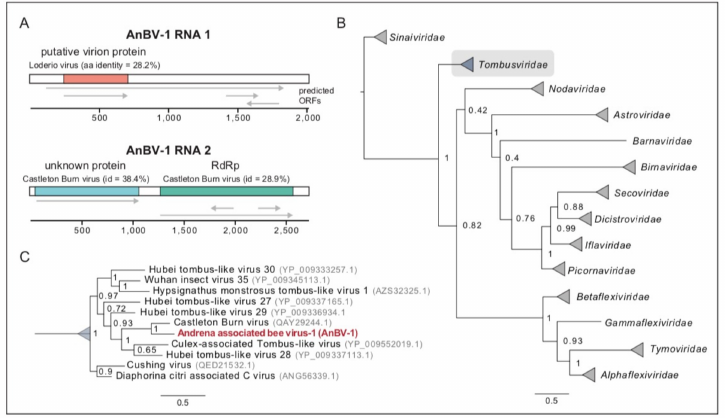
Figure 3. Andrena-associated bee virus-1 is a bipartite RNA tombus-like virus. ( A ). Schematic diagram of AnBV-1 genome, RNA 1 and RNA 2, with predicted open reading frames (ORFs) labeled with gene annotations based on PHMMER, HHpred and BLAST analyses and corresponding percent amino acid identity. ( B ). The AnBV-1 RdRp sequence forms a well-supported monophyletic clade with sequences in the Tombusviridae family (highlighted in gray). The AnBV-1 phylogenetic relationship was inferred from a maximum likelihood consensus tree of insect viruses, including previously described honey bee viruses in the Sinaiviridae , Dicistroviridae , and Iflaviridae families. Numbers on branches are Bayesian posterior probabilities (0–1); the scale bar indicates substitutions per site, and GenBank accession numbers for either the RdRp sequences or the genome sequences from where the RdRp sequence obtained are in parentheses. ( C ). Detailed view of the Tombusviridae clade in panel ( B ), illustrated that AnBV-1 RdRp is most similar to Castleton burn virus and Hubei tombus-like viruses. GenBank accessions are indicated in gray.